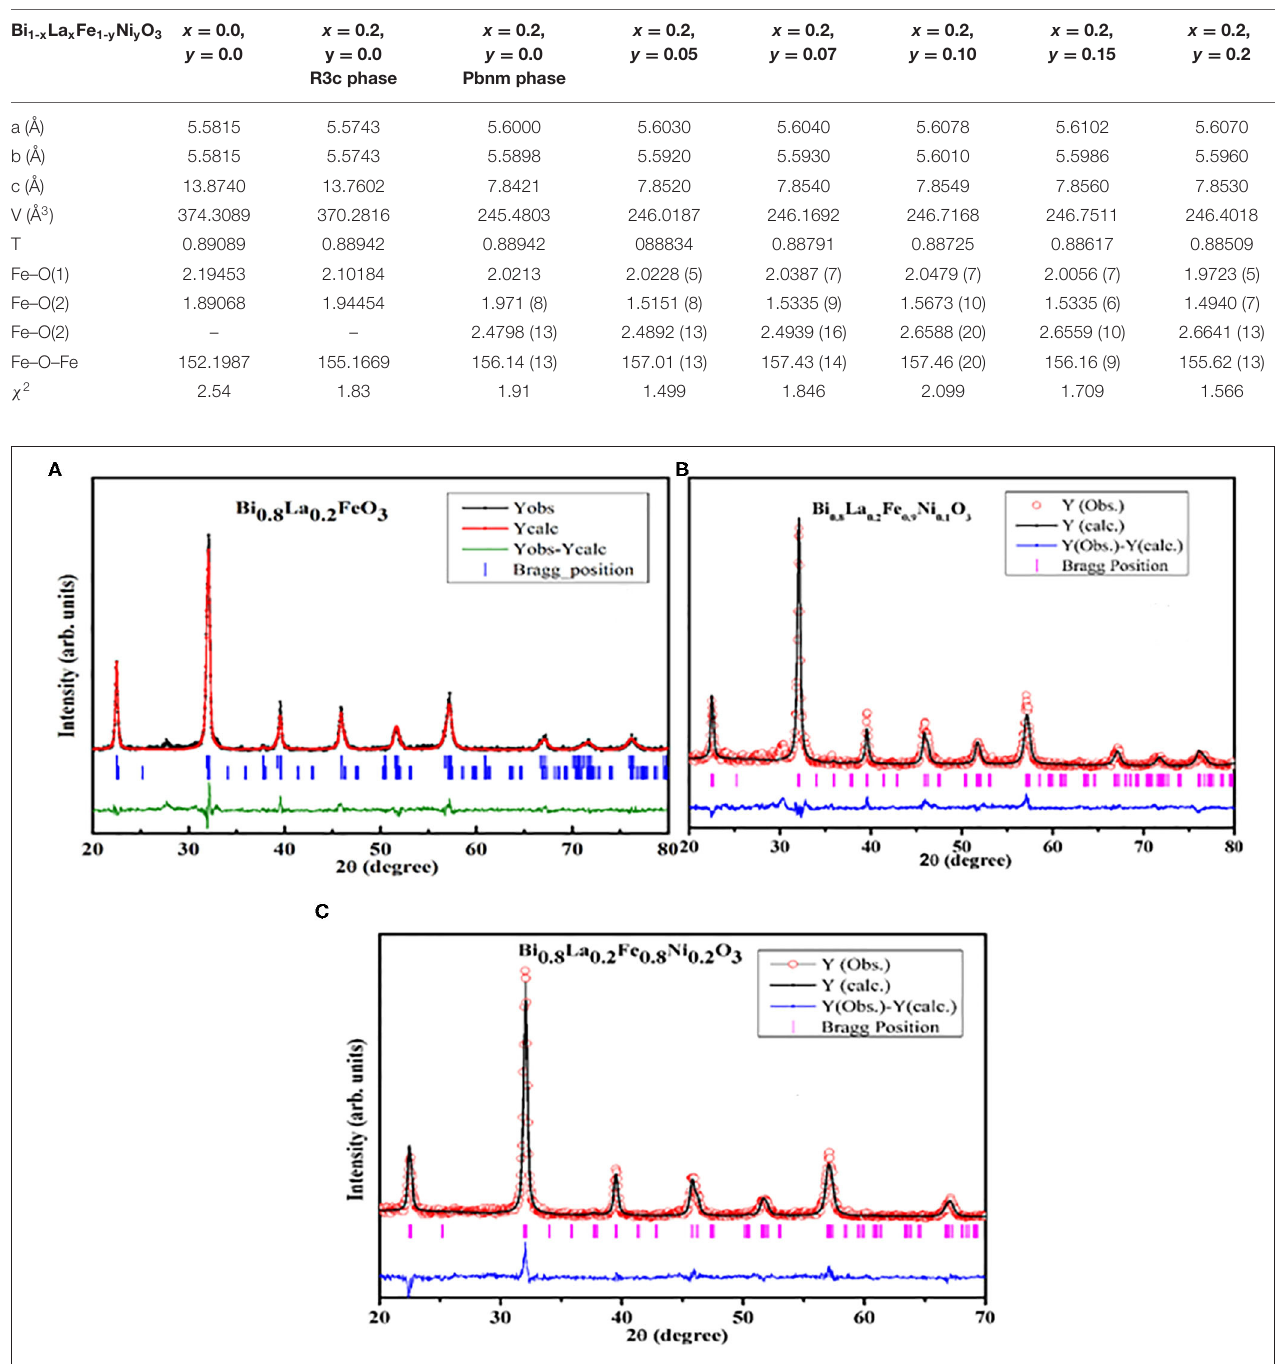
TABLE 1 | Refined structural parameters and tolerance factors of Bi 1